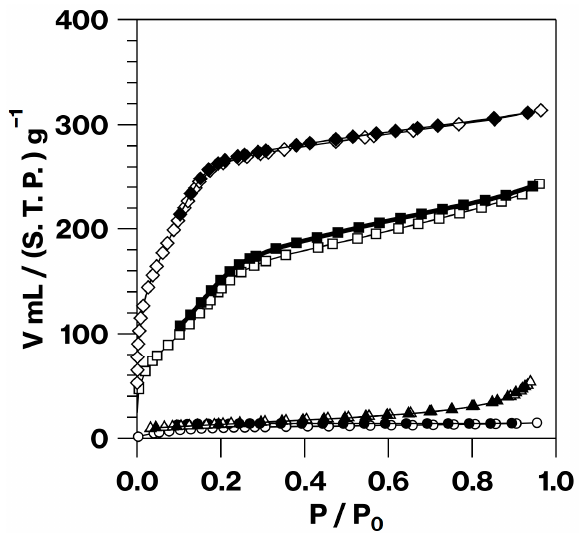
Figure 7. N 2 adsorption/desorption isotherms for ASP (circles), P25 (triangles), C25P25–ASP (squares), and CSP (diamonds). Open and filled symbols represent adsorption and desorption, respectively. The solid lines are visual aids. Table 2. List of BET surface areas, BJH pore sizes, or pore volumes for ASP, P25, Cu–P25–ASP, and CSP.